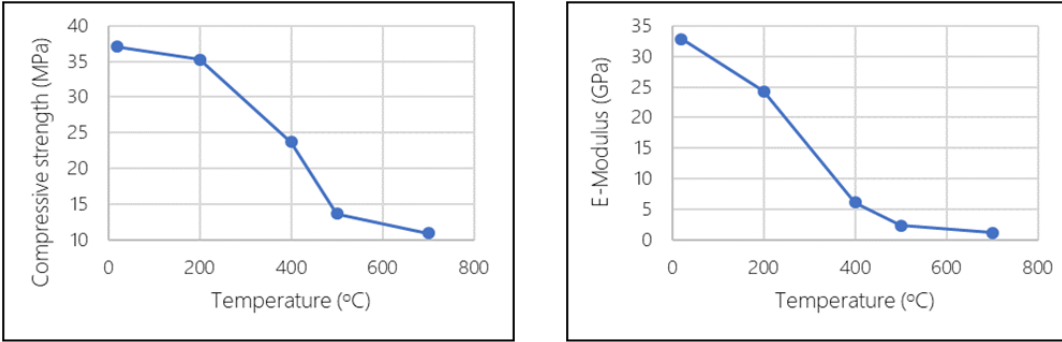
Figure 8. Reduction of compressive strength and elastic modulus of textile reinforced concrete (TRC) specimens after exposure to elevated temperatures. Table 4. Reduction of compressive strength and elastic modulus of TRC after exposure to high